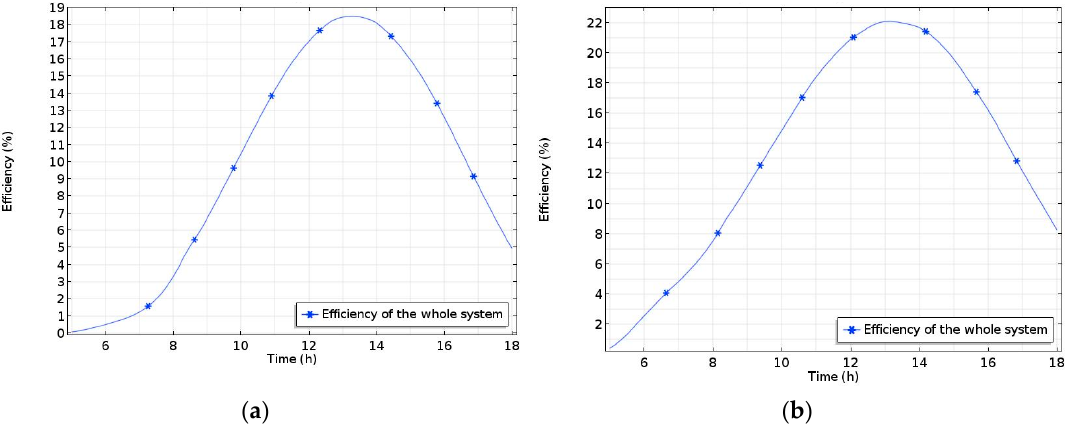
Figure 15. Efficiency of the whole systems: ( a ) covered CPC system (17 July 2017); ( b ) uncovered CPC system (18 July 2017).